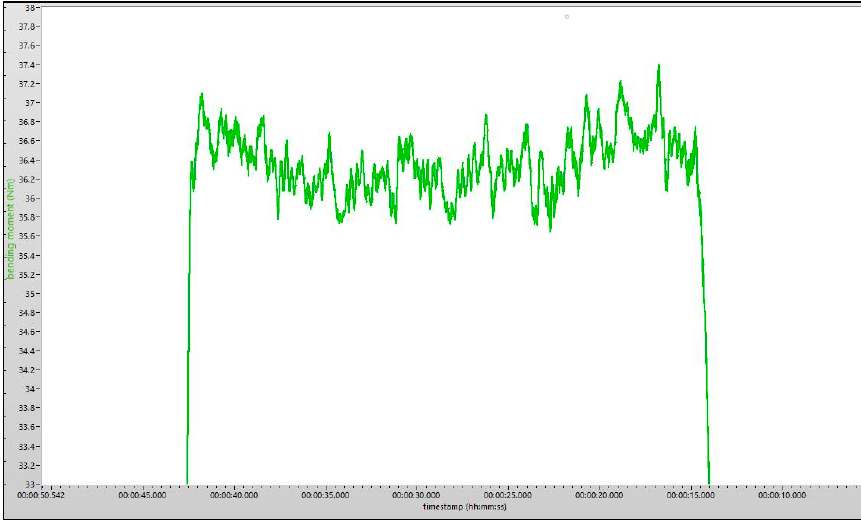
Figure 5. The bending moment signals.